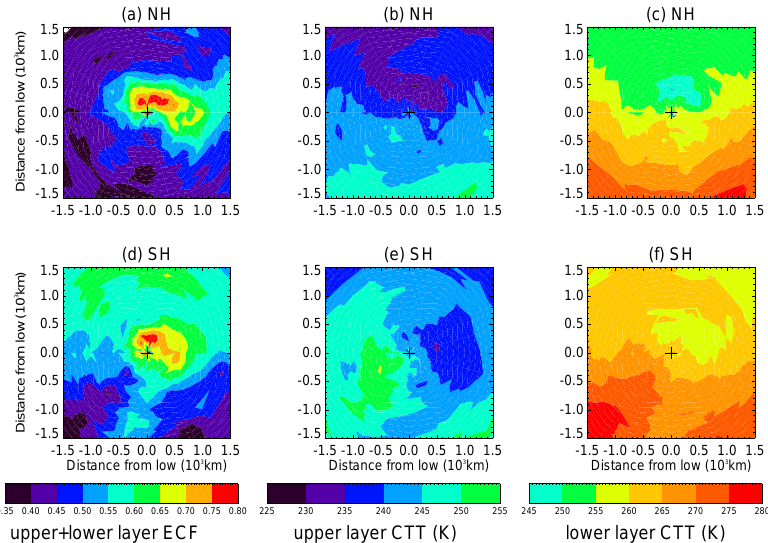
Fig. 15. Midlatitude cyclone composites for January 2007 for the total ECF, upper-level T C , and lower-level T C in the (a) – (c) NH and (d) – (f) SH.